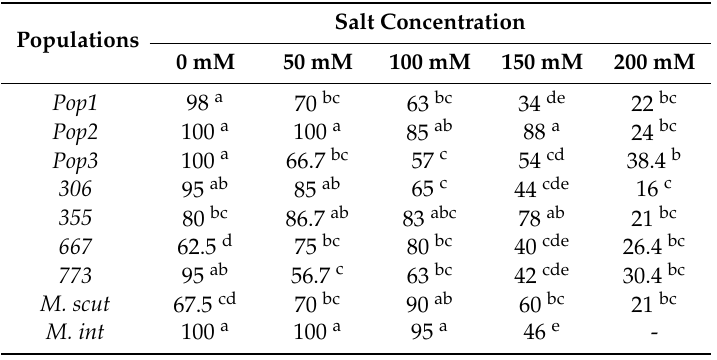
Table 1. Final germination percentage (FGP) under salt stress (0, 50, 100, 150, 200 mM NaCl) of seven populations of M. ciliaris ( Pop1, Pop2, Pop3, 306, 355, 667, 773 ), compared to one population of M. intertexta ( M. int ) and one population of M. scutellata ( M. scut ). The means are averages of 10